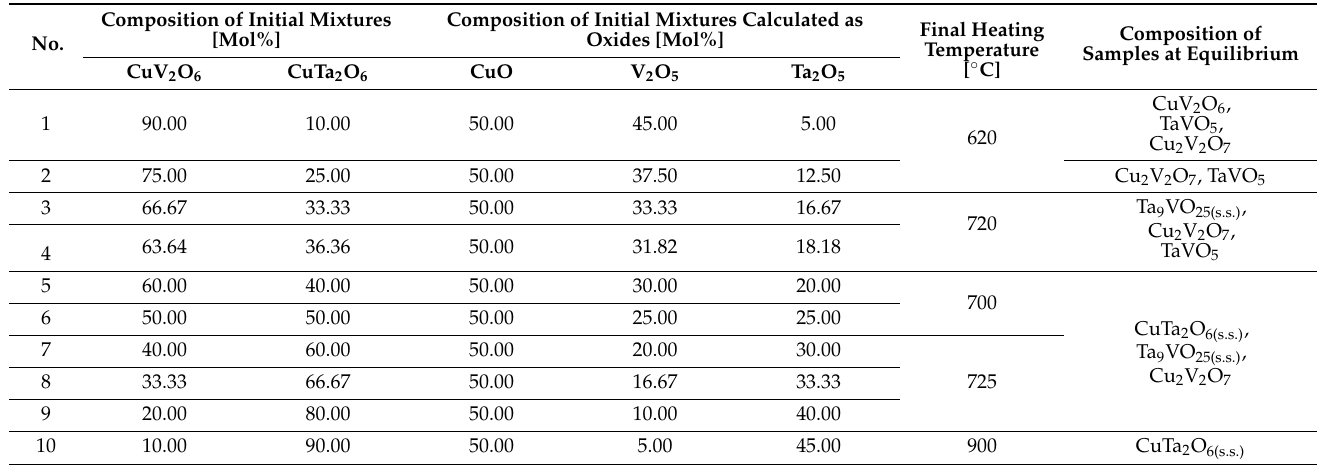
Table 1. The composition of initial mixtures and the results of phase XRD analysis of the samples from the CuV 2 O 6 –CuTa 2 O 6 system after the last heating stage.